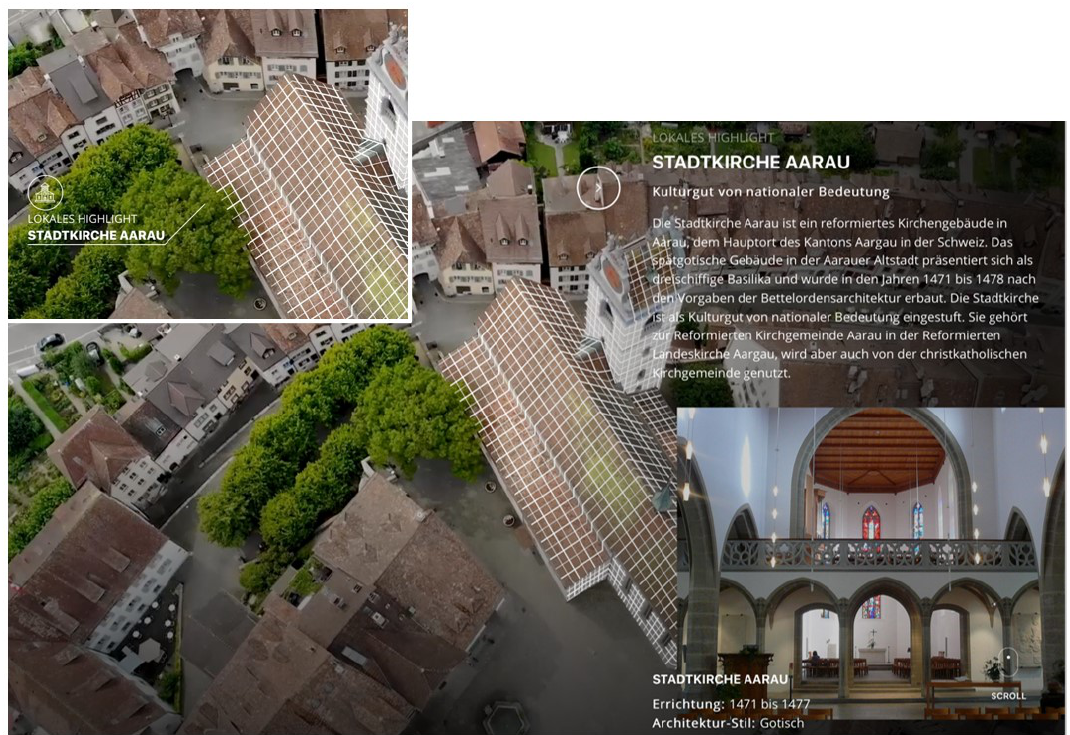
Figure 3b. Image of slide in container with information about the "Stadtkirche Aarau" (Aarau City Church). On the top left, a point-of-interest (POI) annotation is demonstrated. Once the user clicks on this POI, they are shown the overlay on the right panel and they can always dismiss the overlay and continue their